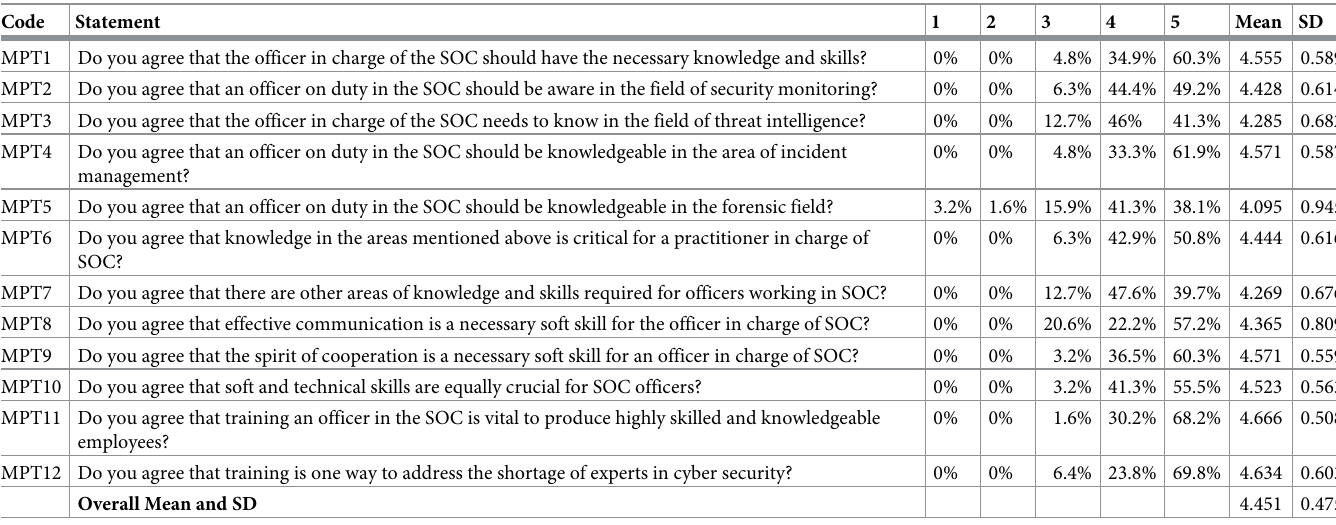
Table 13. Questionnaire results for the human